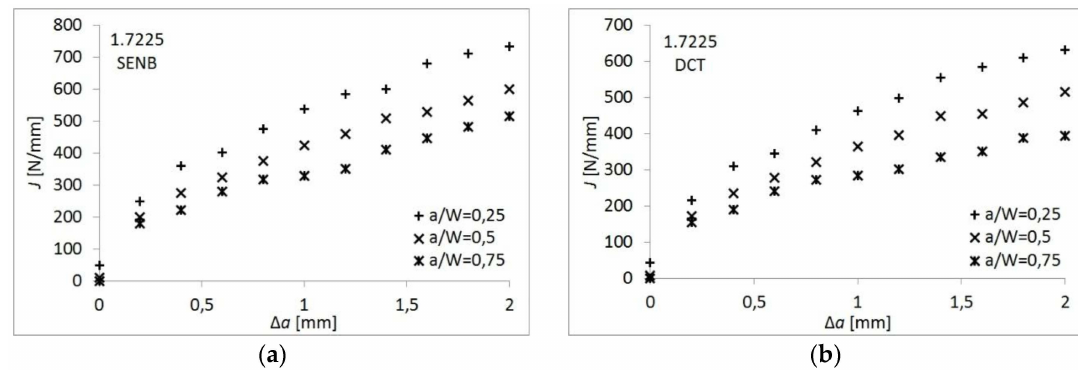
Figure 8. Numerically-predicted J values for steel 1.7225 using FE models of: ( a ) SENB specimen; ( b ) DCT